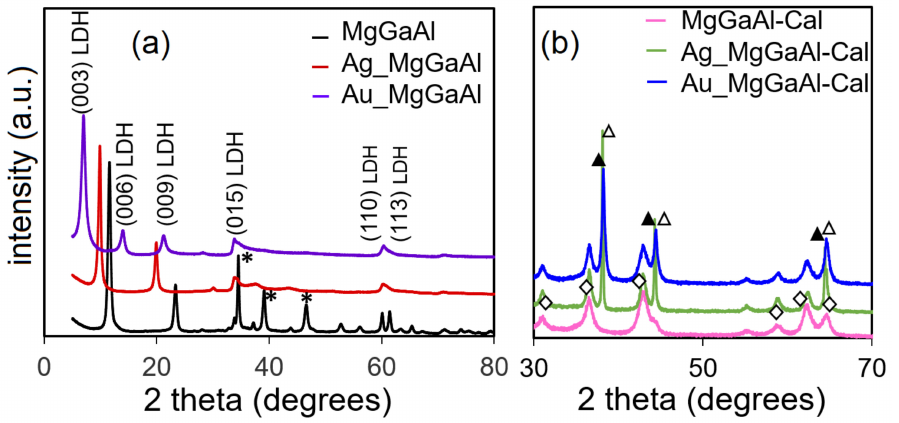
Figure 1. XRD patterns of ( a ). MgGaAl, Ag_MgGaAl and Au_MgGaAl; ( b ) after calcination at 870 ◦ C. ( * ) GaOOH; ∆ Au and (cid:78) Ag; ♦ MgGa 2 O 4